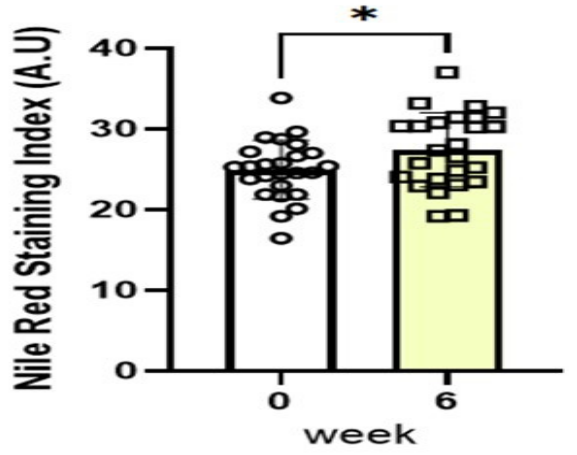
Figure 10. Effects on corneocyte size, degree of thick abrasions, and Nile red dye staining in the tape-stripped SC. ( A ): Corneocyte size, n = 25; ***: p < 0.001, compared to week 0; data were analyzed using the Wilcoxon signed-rank sum test and are expressed as means ± SD. ( B ): Thick abrasions, n = 25; ****: p < 0.0001, compared to week 0; data were analyzed using the paired t test and are expressed as means ± SD. ( C ): Nile red dye staining, n = 25; *: p < 0.05, compared to week 0; data were analyzed using the paired t test and are expressed as means ± SD.